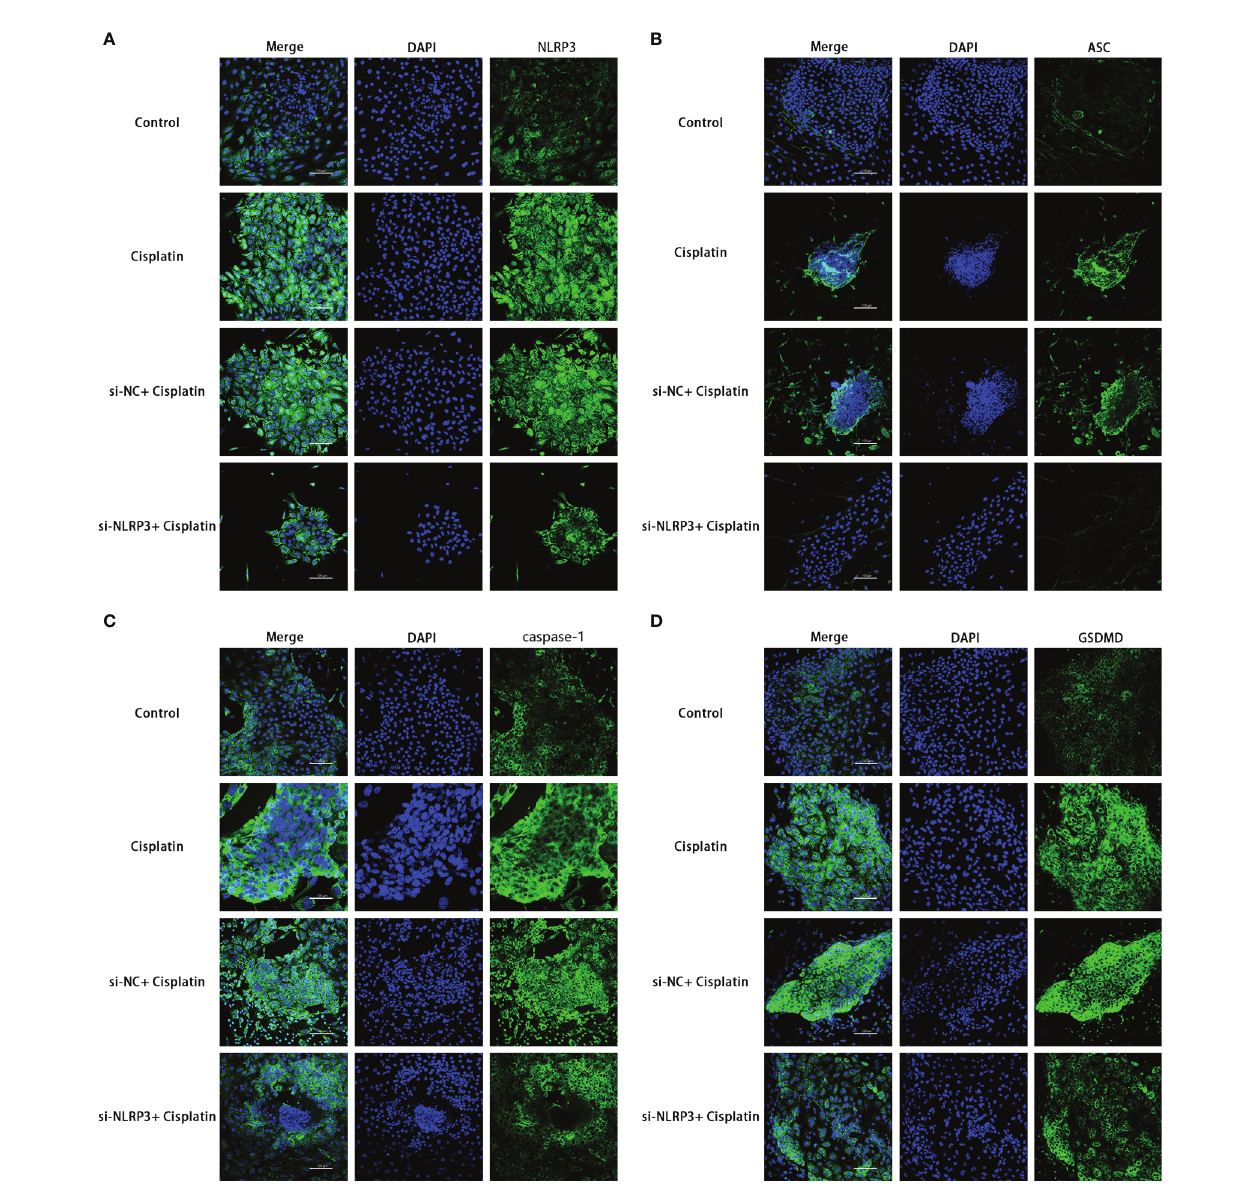
FIGURE 6 | The expression differences of NLRP3, ASC, caspase-1, and GSDMD in the control, cisplatin, cisplatin+siNC, and cisplatin+siNLRP3 groups. Blue fl uorescence indicates DAPI-labeled cell nuclei, and green fl uorescence indicates FITC-labeled target proteins. Representative results of at least three repeated experiments are shown. Scale bar: 100